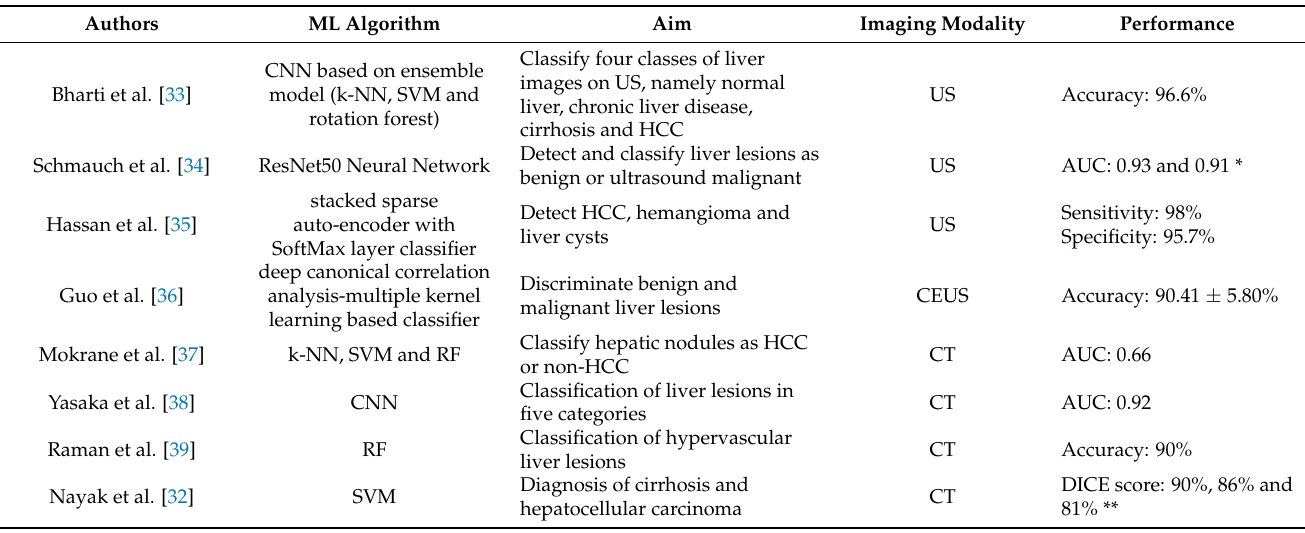
Table 2. Overview of ML algorithms applied to hepatocellular carcinoma